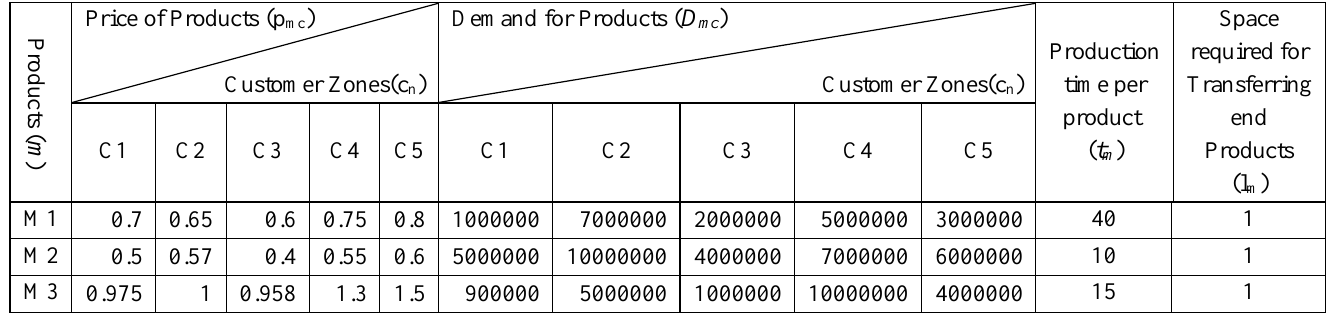
Table 3- The Price of each product, construction time, and space required for end products